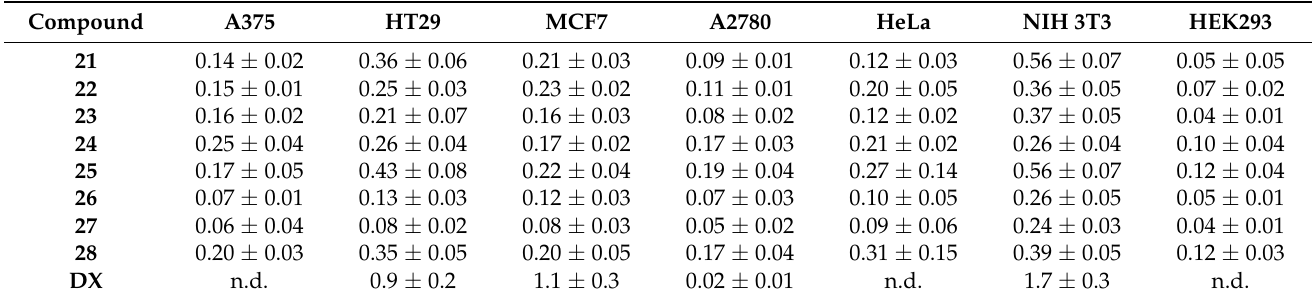
Table 4. Cytotoxicity of 3- O -acetylated triterpenoic amides holding a distal rhodamine 101 unit 13 – 20 (EC 50 -values in µ M from SRB-assays) after 72 h of treatment; the values are averaged from three inde- pendent experiments performed each in triplicate, confidence interval CI = 95%; mean ± standard mean error); n.d. not determined; n.s. not soluble; doxorubicin ( DX ) was used as a positive control. Cell lines: malignant: A375 (melanoma), HT29 (colon adenocarcinoma), MCF-7 (breast adenocarci- noma), A2780 (ovarian carcinoma), HeLa (cervical cancer); non-malignant: NIH 3T3 (fibroblasts), HEK293 (human embryonic